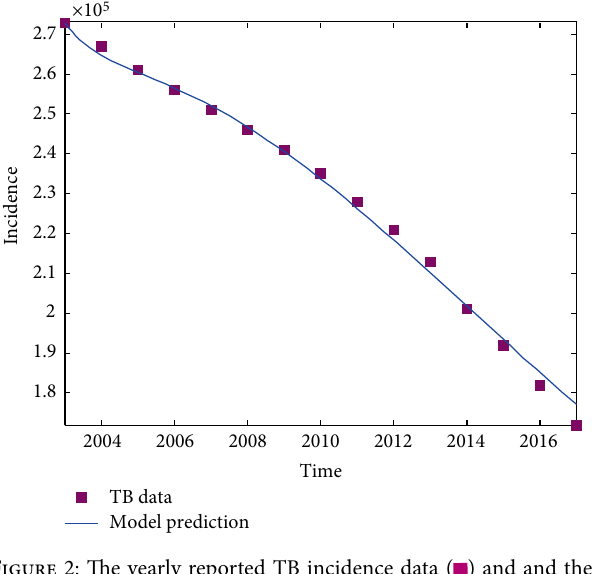
Figure 2: The yearly reported TB incidence data ( ) and and the corresponding best fit (solid blue curve) of 𝑘𝐸(𝑡) .